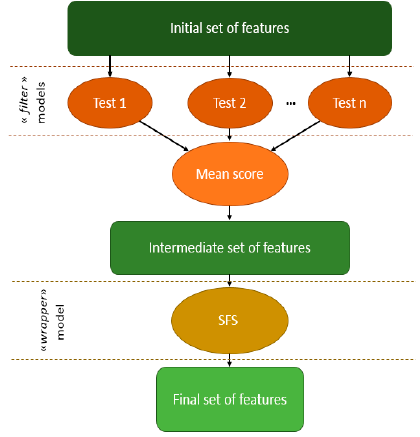
Figure 16. The hybrid model for feature selection. Table 5. List of the best «Direct» features obtained with the method dir_hybride_1 (dir_filter_1 (Test2) and wrapper).